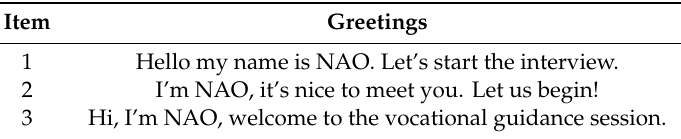
Table 5. Script: greeting protocols.